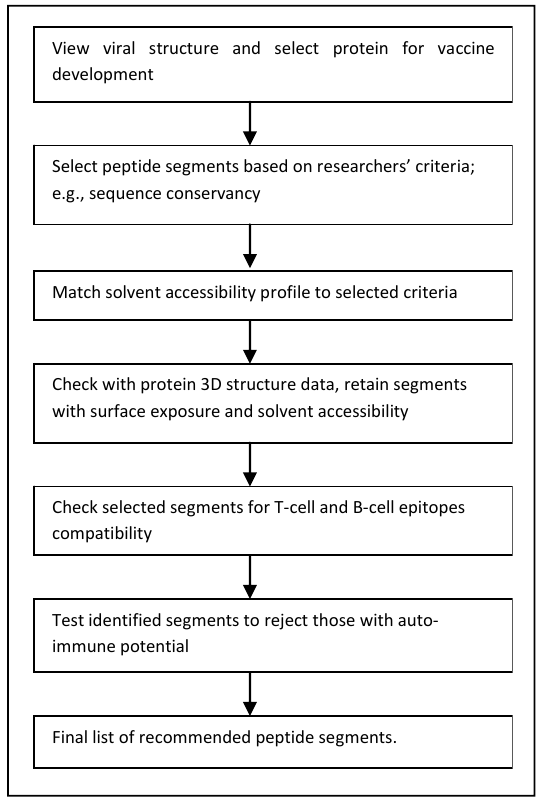
Figure 1. Work flow chart of peptide selection process, as in References [26–28].